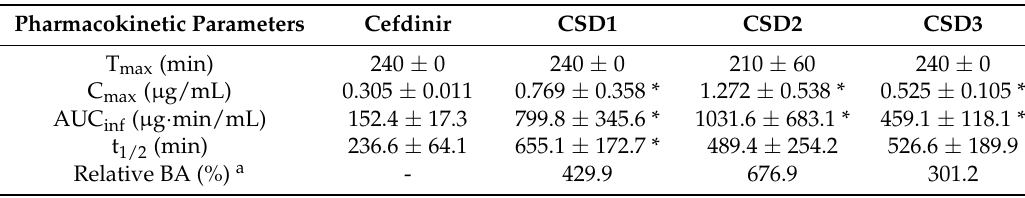
Table 2. Pharmacokinetic parameters of cefdinir after oral administration of cefdinir, CSD1, CSD2, and CSD3, at a dose of 2 mg/kg in rats ( n =